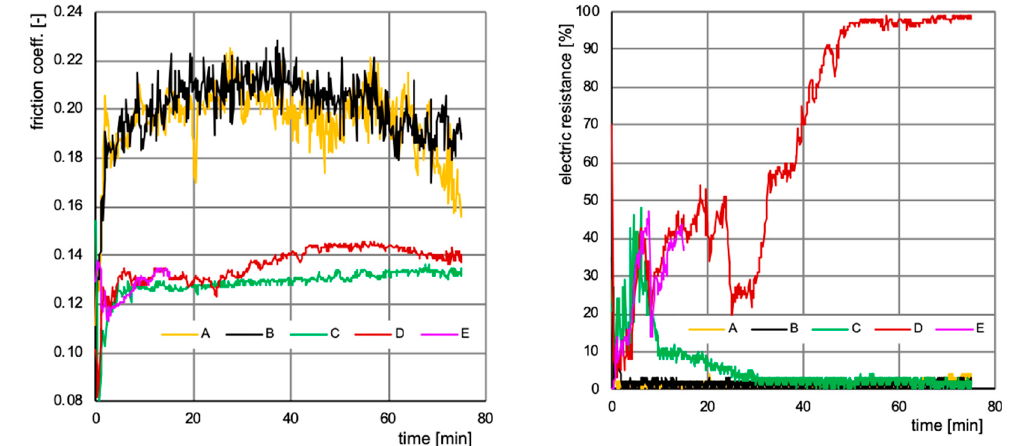
Figure 2. Dynamic friction coefficient ( left ) and resistance ( right ) between the rubbing surfaces measured during the HFRR test for samples A–E.